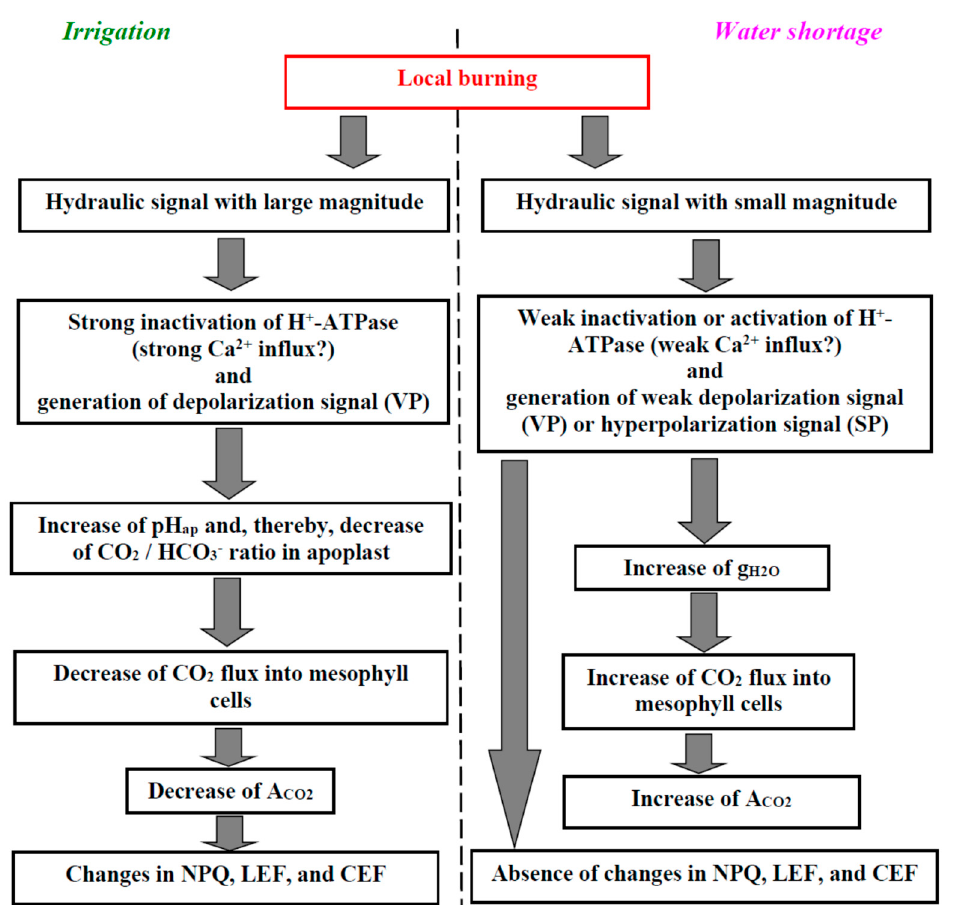
Figure 9. Hypothetical scheme of the influence of local burning on photosynthetic processes in non-damaged leaves under control conditions (irrigated plants) and under strong water shortage (see Section 3). See works [7,44] for details of ES influence on photosynthesis in irrigated plants; details of the ES influence on photosynthesis under water shortage are discussed in the text. pH ap is the apoplastic pH.